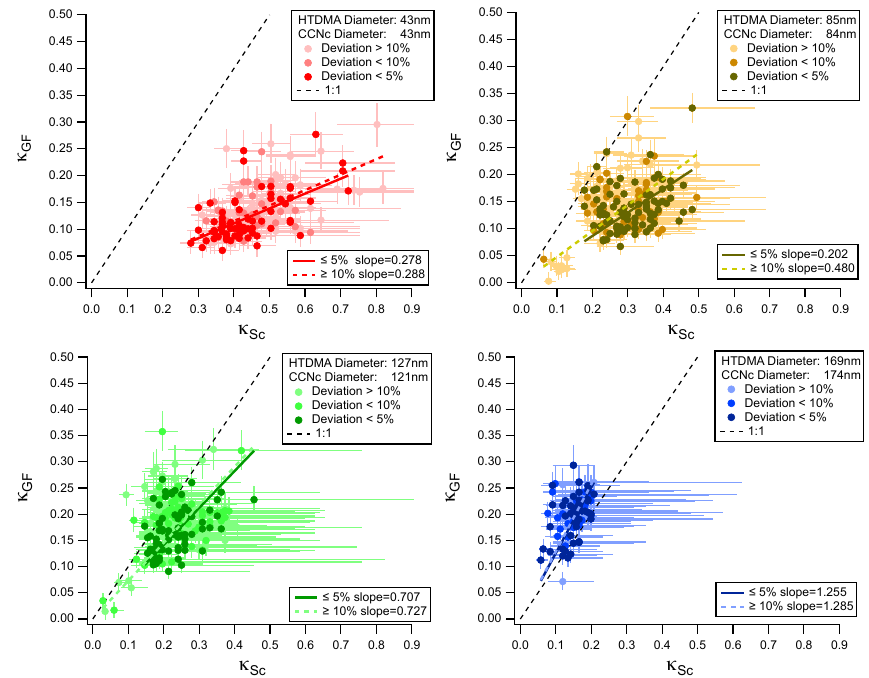
Fig. 5. κ GF plotted against κ S for the CCN dry diameters closest to those of the measured by the HTDMA. The data is colour weighted c according to the proximity of the peak of the growth factor relative to that of the mean growth factor, with the most solid colours representing a deviation below